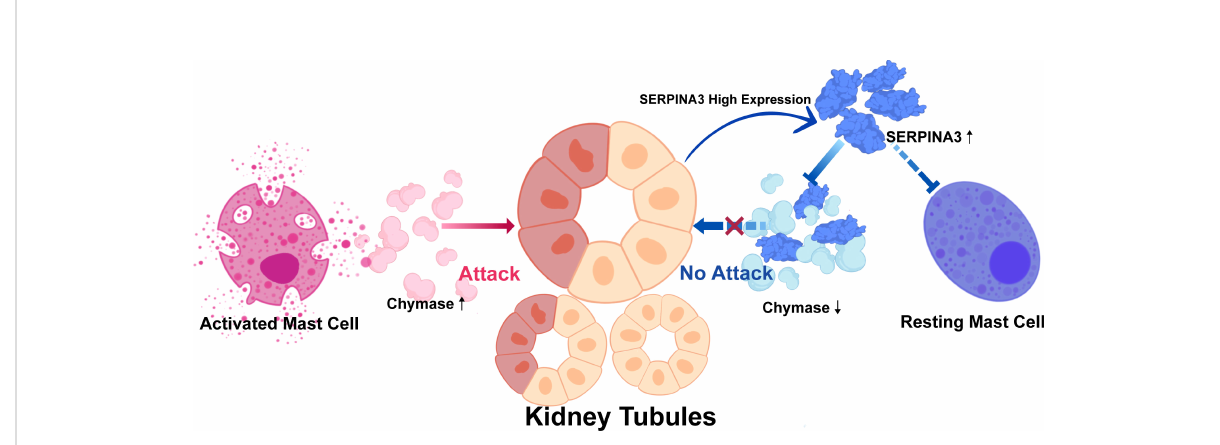
FIGURE 9 Protective mechanism of SERPINA3 in kidney tubules in response to damage by